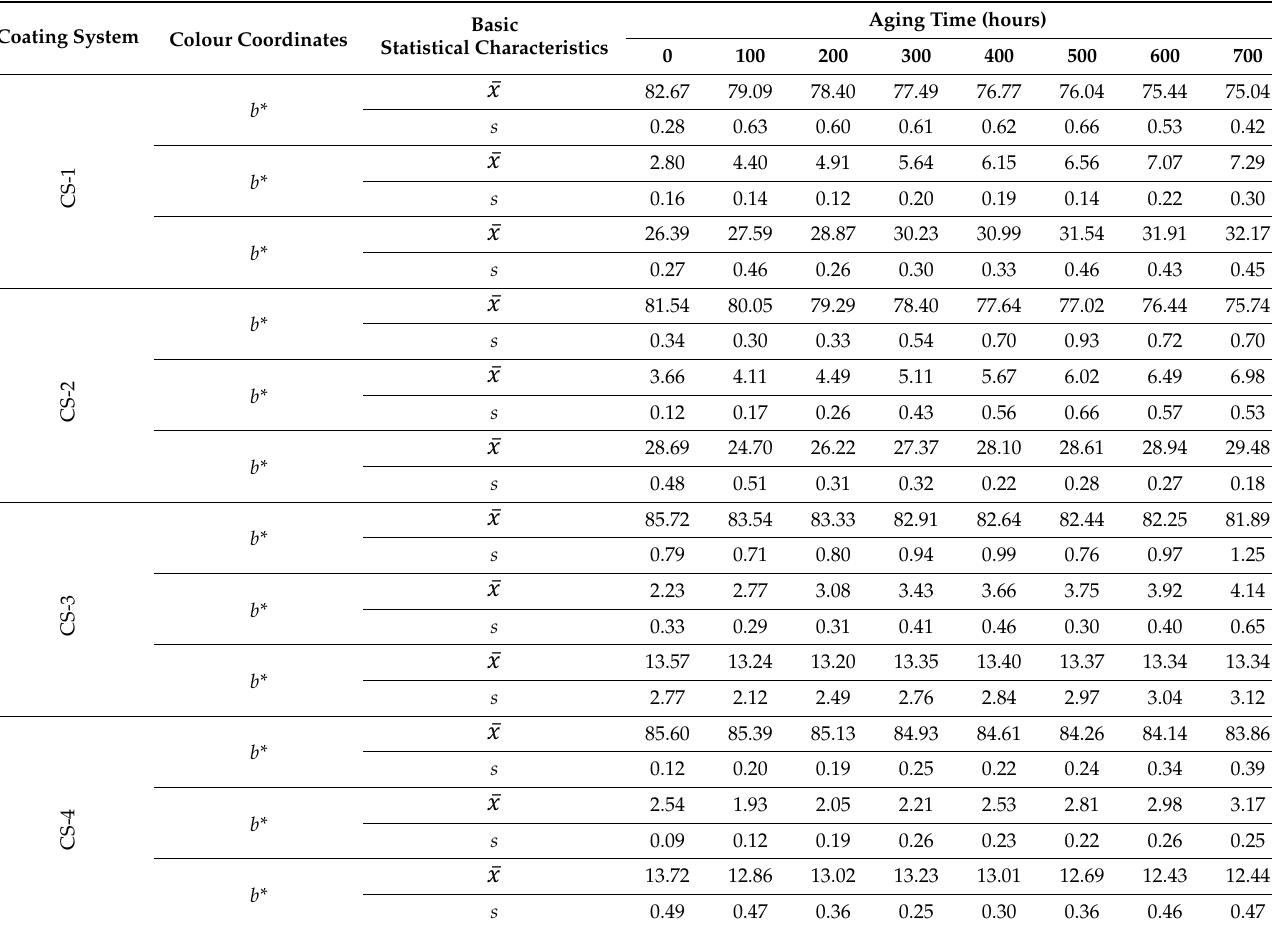
Table 3. Basic statistical characteristics of colour coordinates L * , a * , and b * corresponding to different phases of the accelerated aging process of spruce wood surface-treated with polyurethane lacquers. (The number of measurements for each set n = 50.)